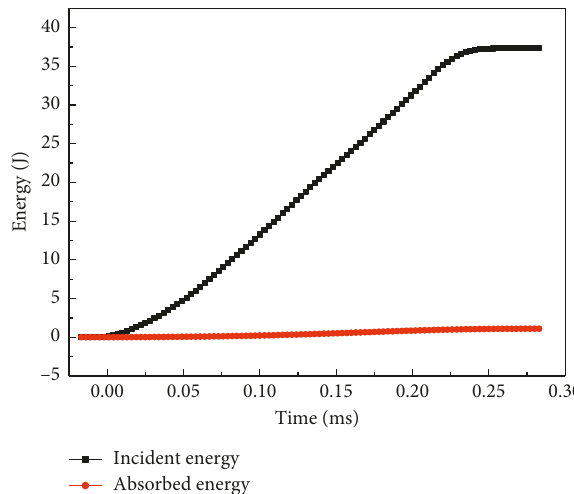
Figure 5: Curves of incident energy and absorbed energy over time in the SHPB test.